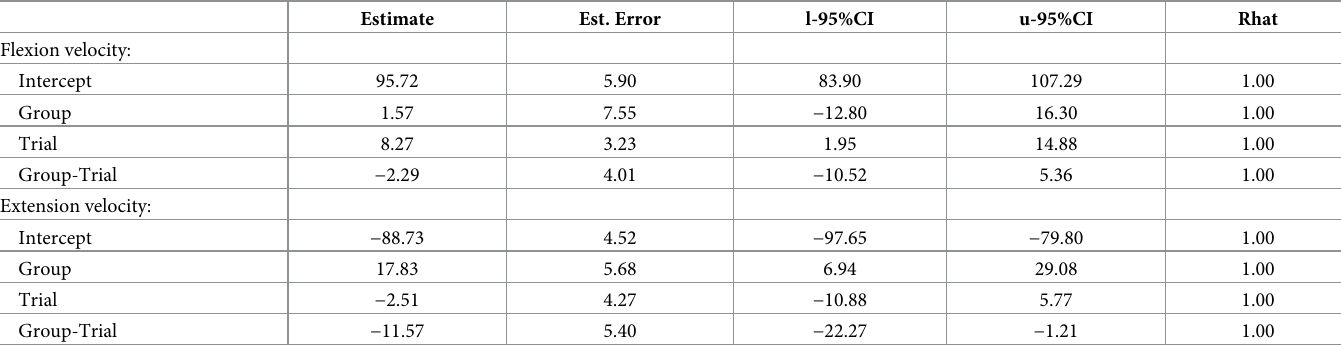
Table 3. Results of comparison kinematic features between the groups.